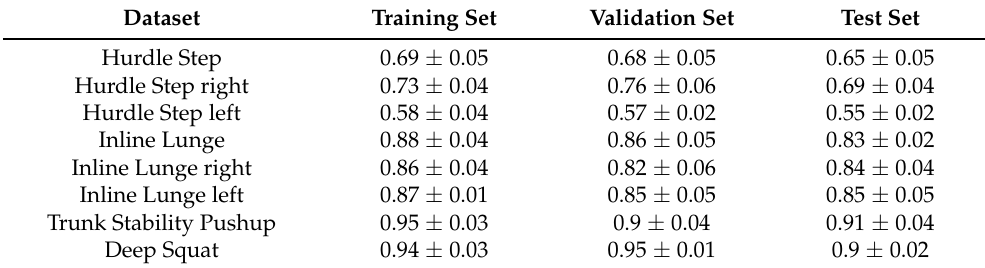
Table 3. Results of the evaluation of the proposed approach on different datasets. For each dataset a 5-fold CV is performed and the arithmetic mean of the macro F1-scores of training, validation and test set is shown, together with the corresponding standard